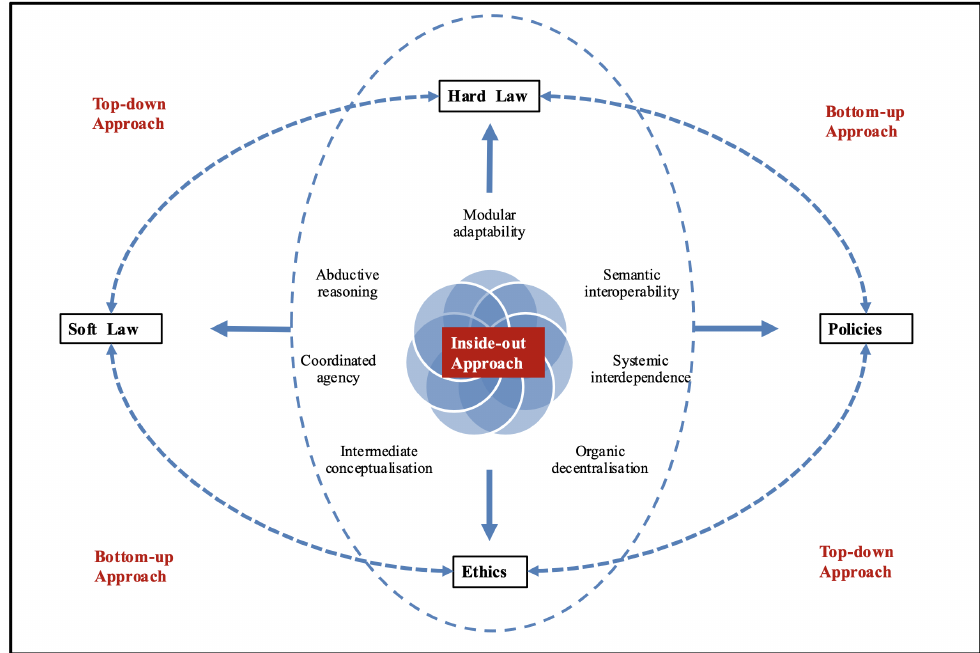
Figure 2. AI4People: SMART Good Governance Model (adopted from Pagallo et al. [12,156]).